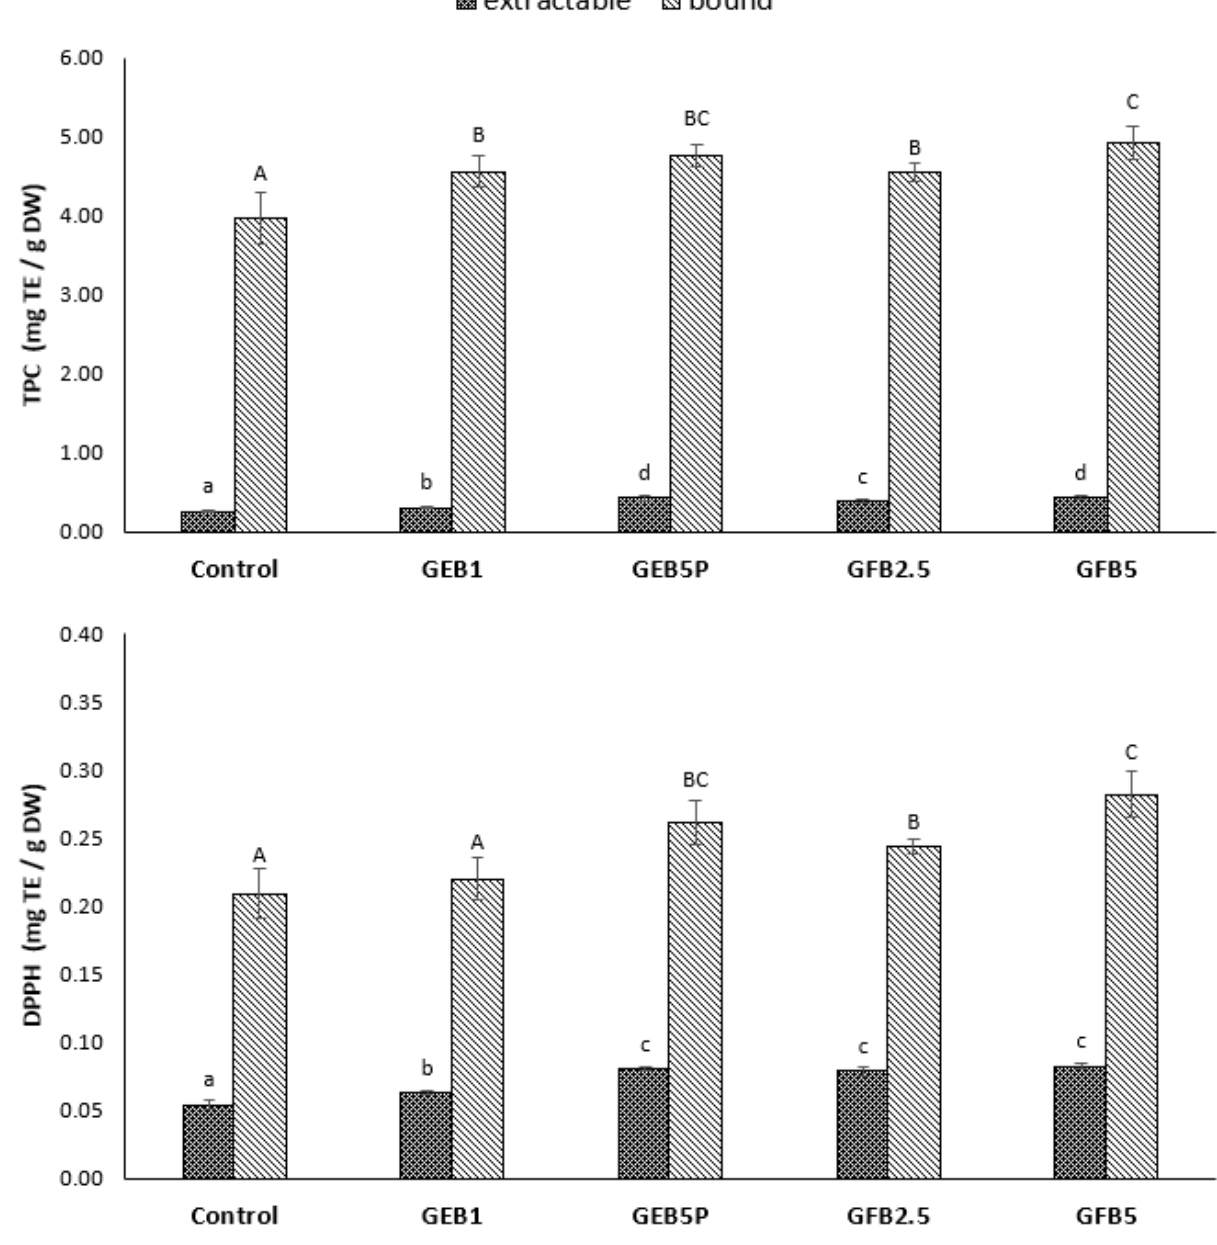
Figure 2. Total phenolic content (TPC) and DPPH • scavenging activity (DPPH) for the extractable and bound fractions of control and bioprocessed breads. Data are means ± SD. Different small letters indicate statistically significant differences between the extractable phenolics ( p < 0.05; Duncan’s multiple range tests). Different capital letters indicated statistically significant differences between the bound phenolics ( p < 0.05; Duncan’s multiple range tests). Control: white wheat bread; GEB1: wheat bread supplemented with 1% “germinated + enzymatic treated” spelt flour; GEB5P: wheat bread supplemented with 5% pasteurised (30 min, 85 °C) “germinated + enzymatic treated” spelt flour; GFB2.5: wheat bread supplemented with 2.5% “germinated + fermented” spelt flour; GFB5: wheat bread supplemented with 5% “germinated + fermented” spelt flour; mg TE/g DW: mg Trolox equivalents per g dry weight.